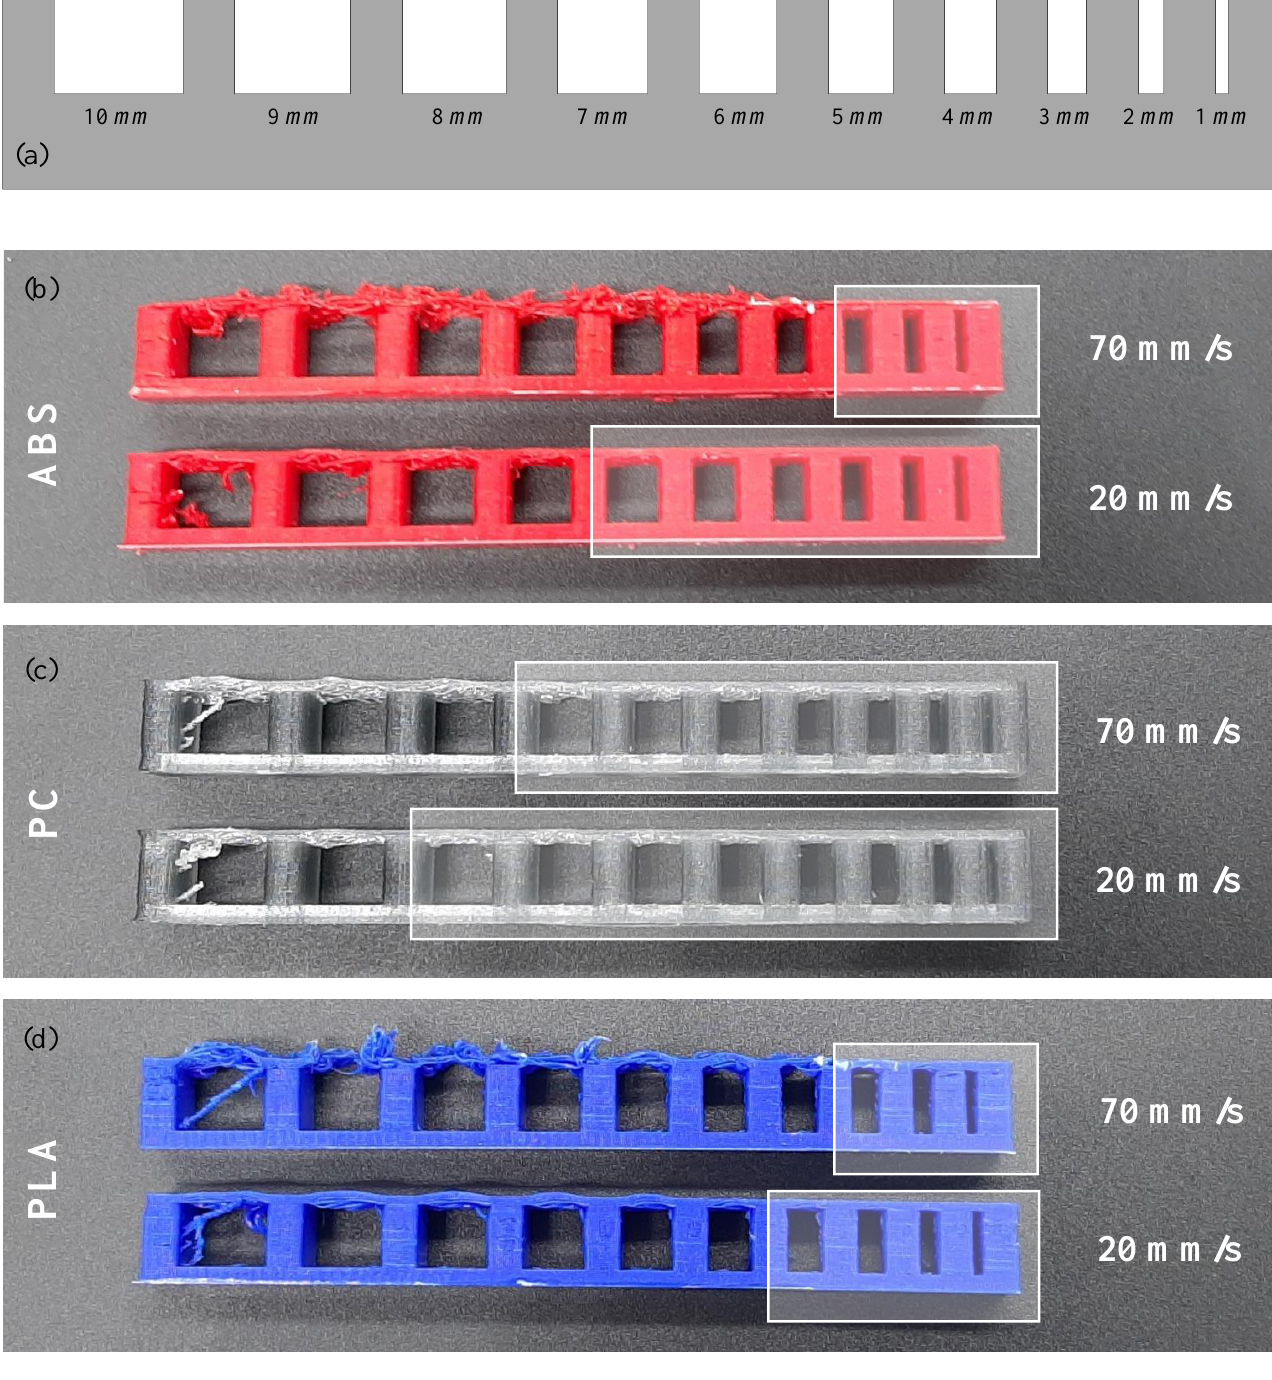
Figure 16. Bridge length test setup and results. ( a ) Sample geometry, ( b ) results for ABS, ( c ) results for PC, and ( d ) results for